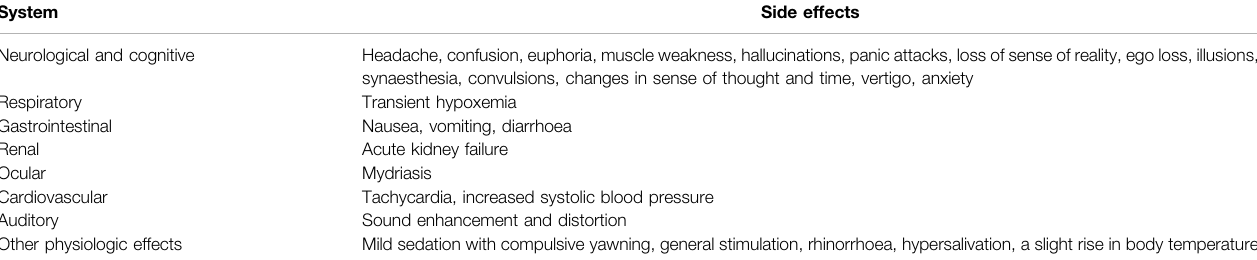
TABLE 1 | The common adverse effects related to psilocybin